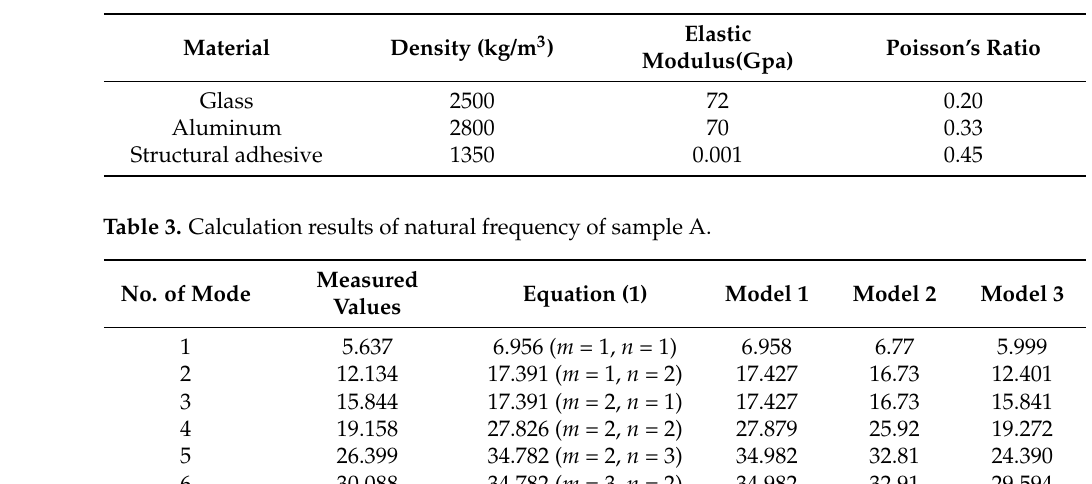
Figure 5. Finite element model of panel unit. Table 2. Physical parameters of materials.